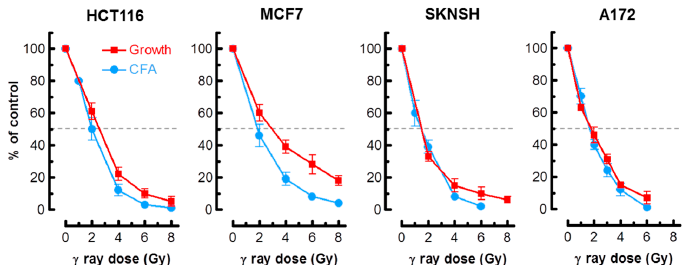
Figure 1. Radiosensitivity of the indicated cell lines evaluated by growth inhibition and colony formation assays. Growth inhibition and colony forming ability measurements were performed 3 days and 10 days post-irradiation, respectively. Bars, standard error (SE). CFA, colony forming ability.